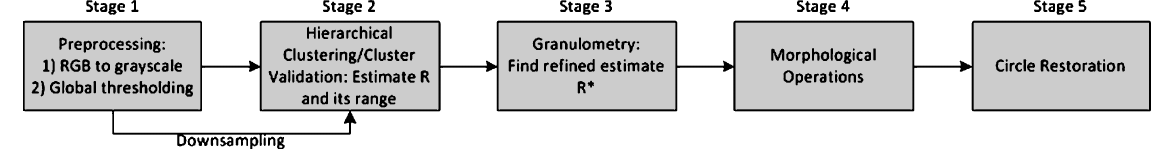
Fig. 1. Flowchart of our method. R represents the approximate radius of the